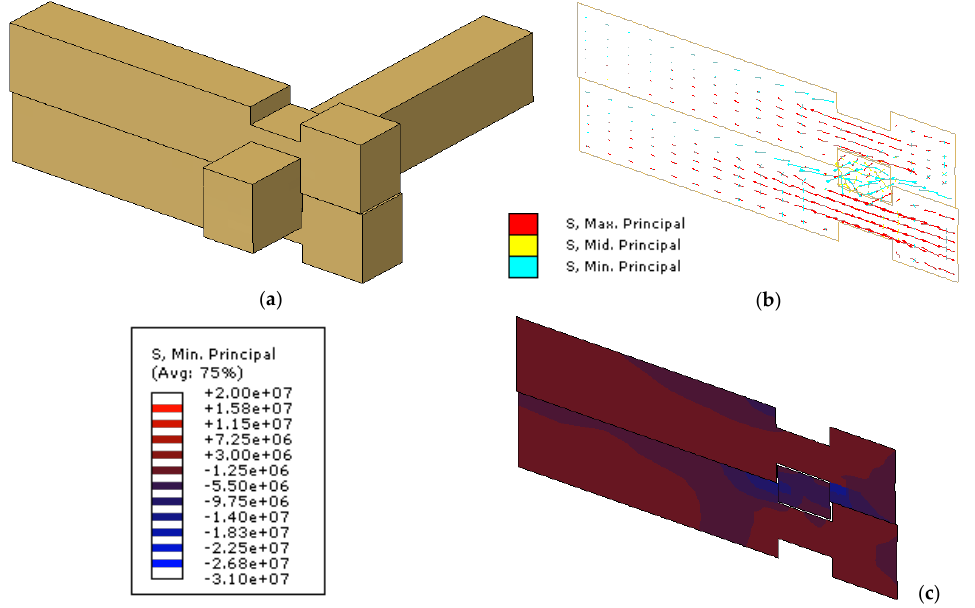
Figure 5. Standard joint under in-plane lateral loads (push-out, P = 10 kN), at an imposed displacement δ = 5 mm (ABAQUS, FE-STRU). ( a ) Deformed shape, with ( b ) distribution of principal stresses (vectorial representation) and ( c ) contour plot of compressive stresses (legend in Pa).